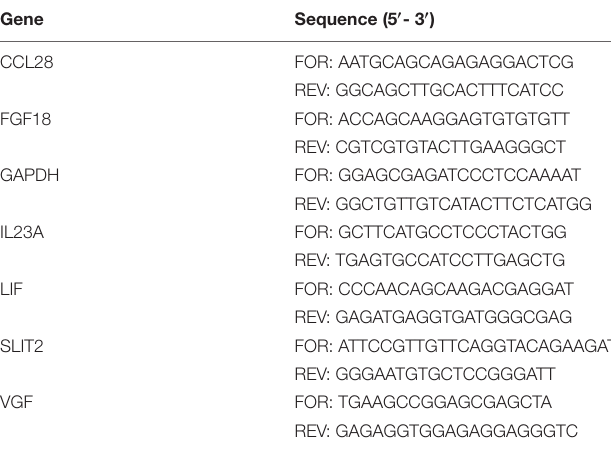
TABLE 1 | The sequences of primers used in real-time PCR.